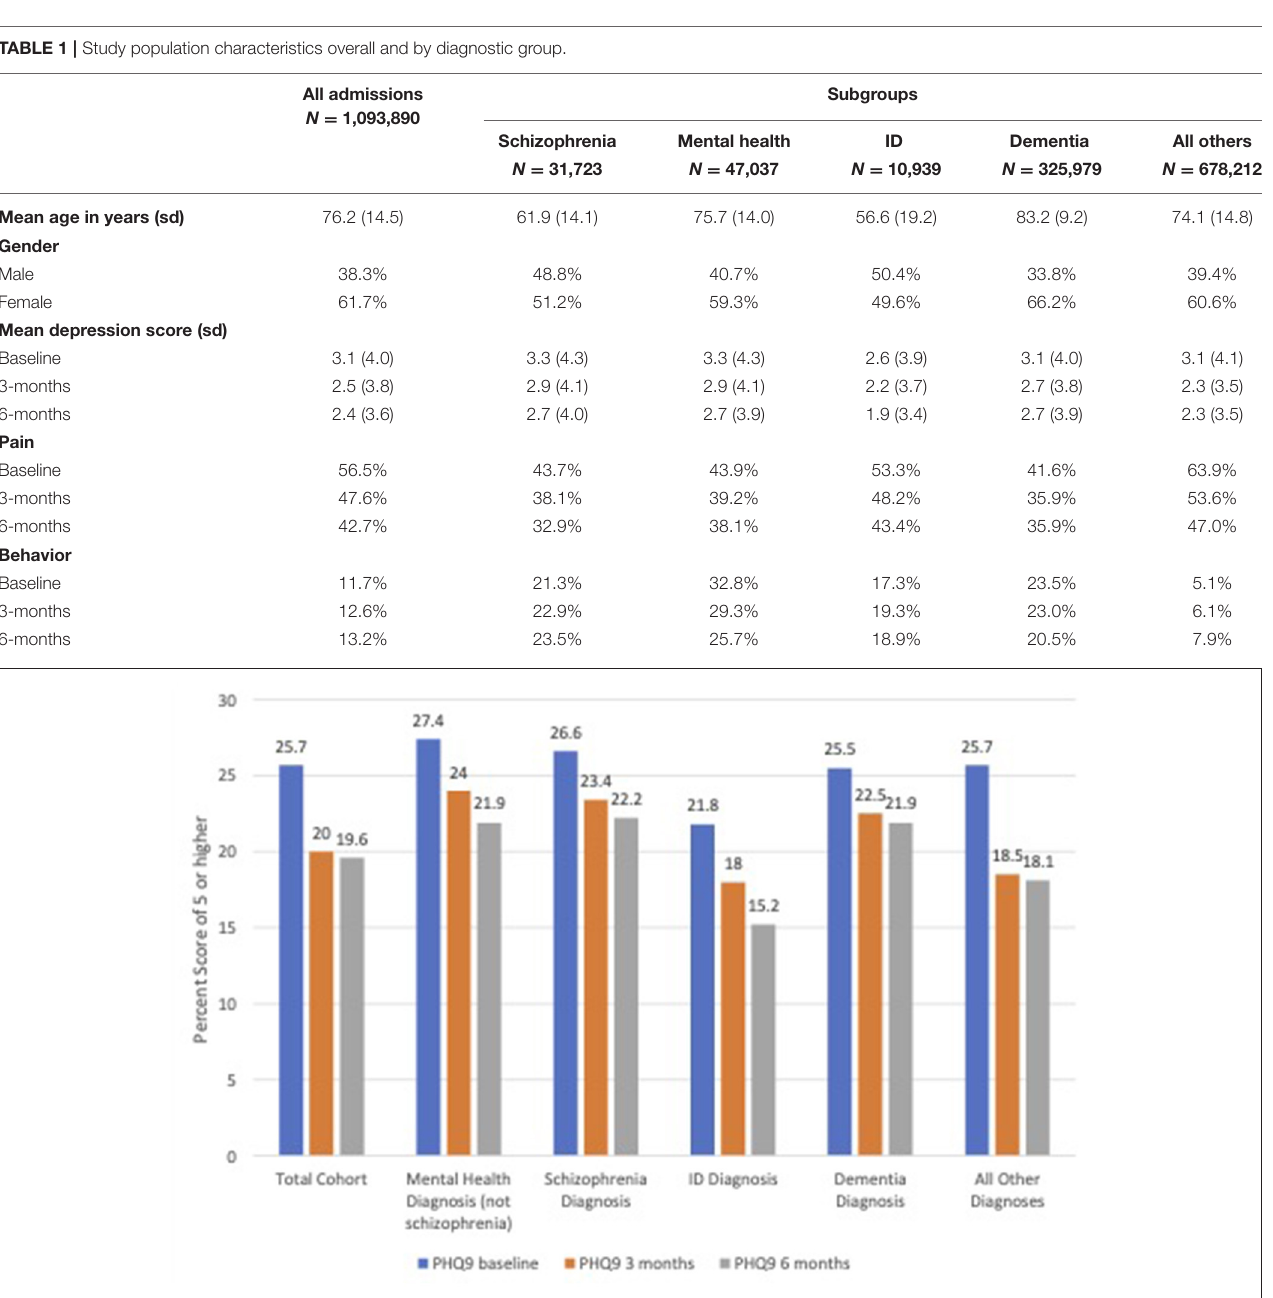
FIGURE 1 | Percent of residents with PHQ-9 score of five or greater at follow-up.